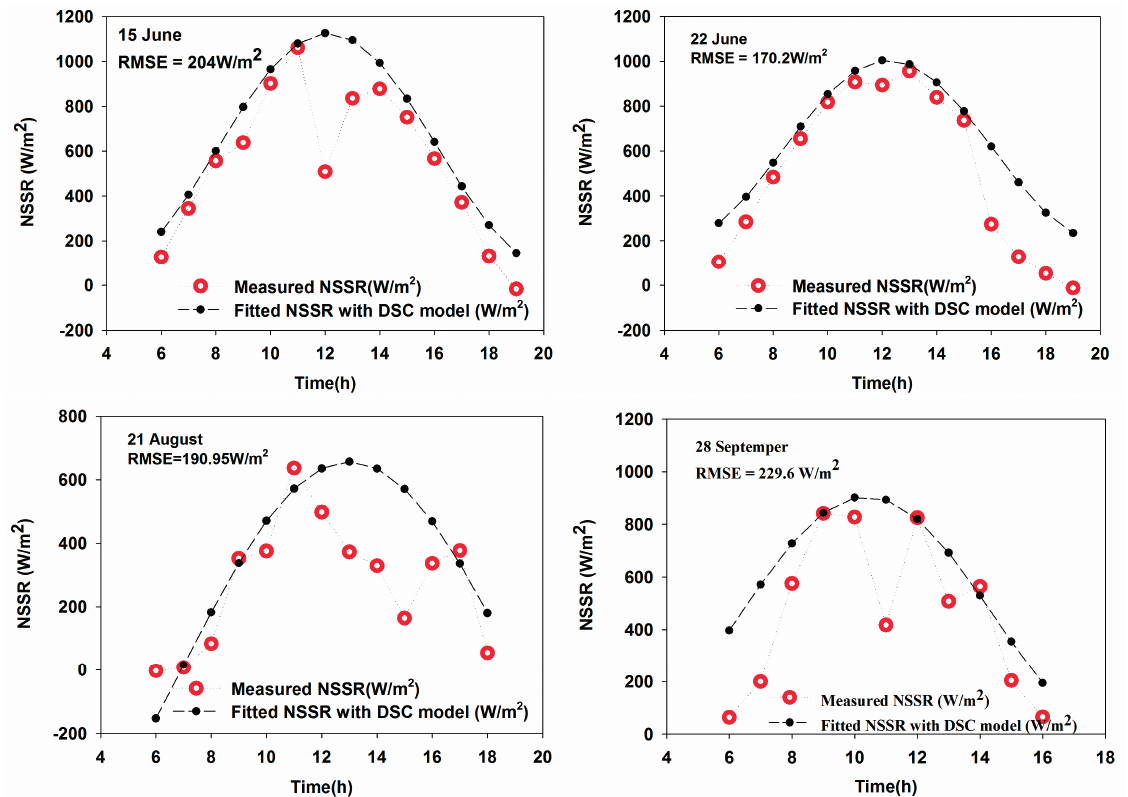
Figure 3. Comparison of the measured daily NSSR evolution with that predicted by the DSC model for six days under various cloud cover